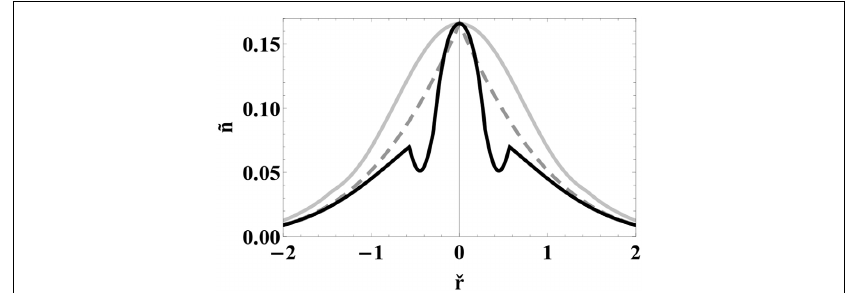
FIGURE 1 | The scaled density profiles of a harmonically trapped Bose gas at the onset of BEC. While the center of the trap ( ˇ r = 0) is set to be at BEC transition, the entire tail of the density profile is in normal state. The interaction strength and temperature are fixed to be U = ¯ h ω and k B T = ¯ h ω . The dashed-line represents a non-interacting Bose gas, the black and gray lines represent t-matrix and Hartree-Fock theories respectively. The density ˜ n = nl 3 and the radial (cid:5) ¯ h / m ω . coordinate ˇ r = r / l are scaled with the oscillator length l =